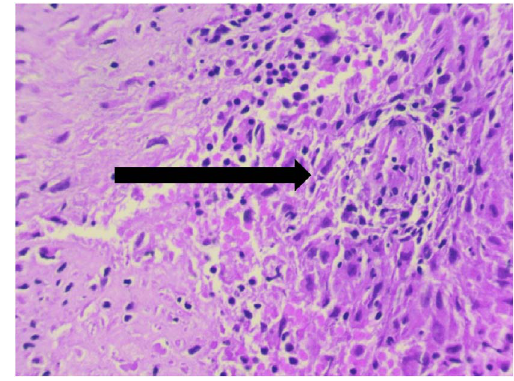
Figure 5. Langhans giant cells demonstrated by an arrow.